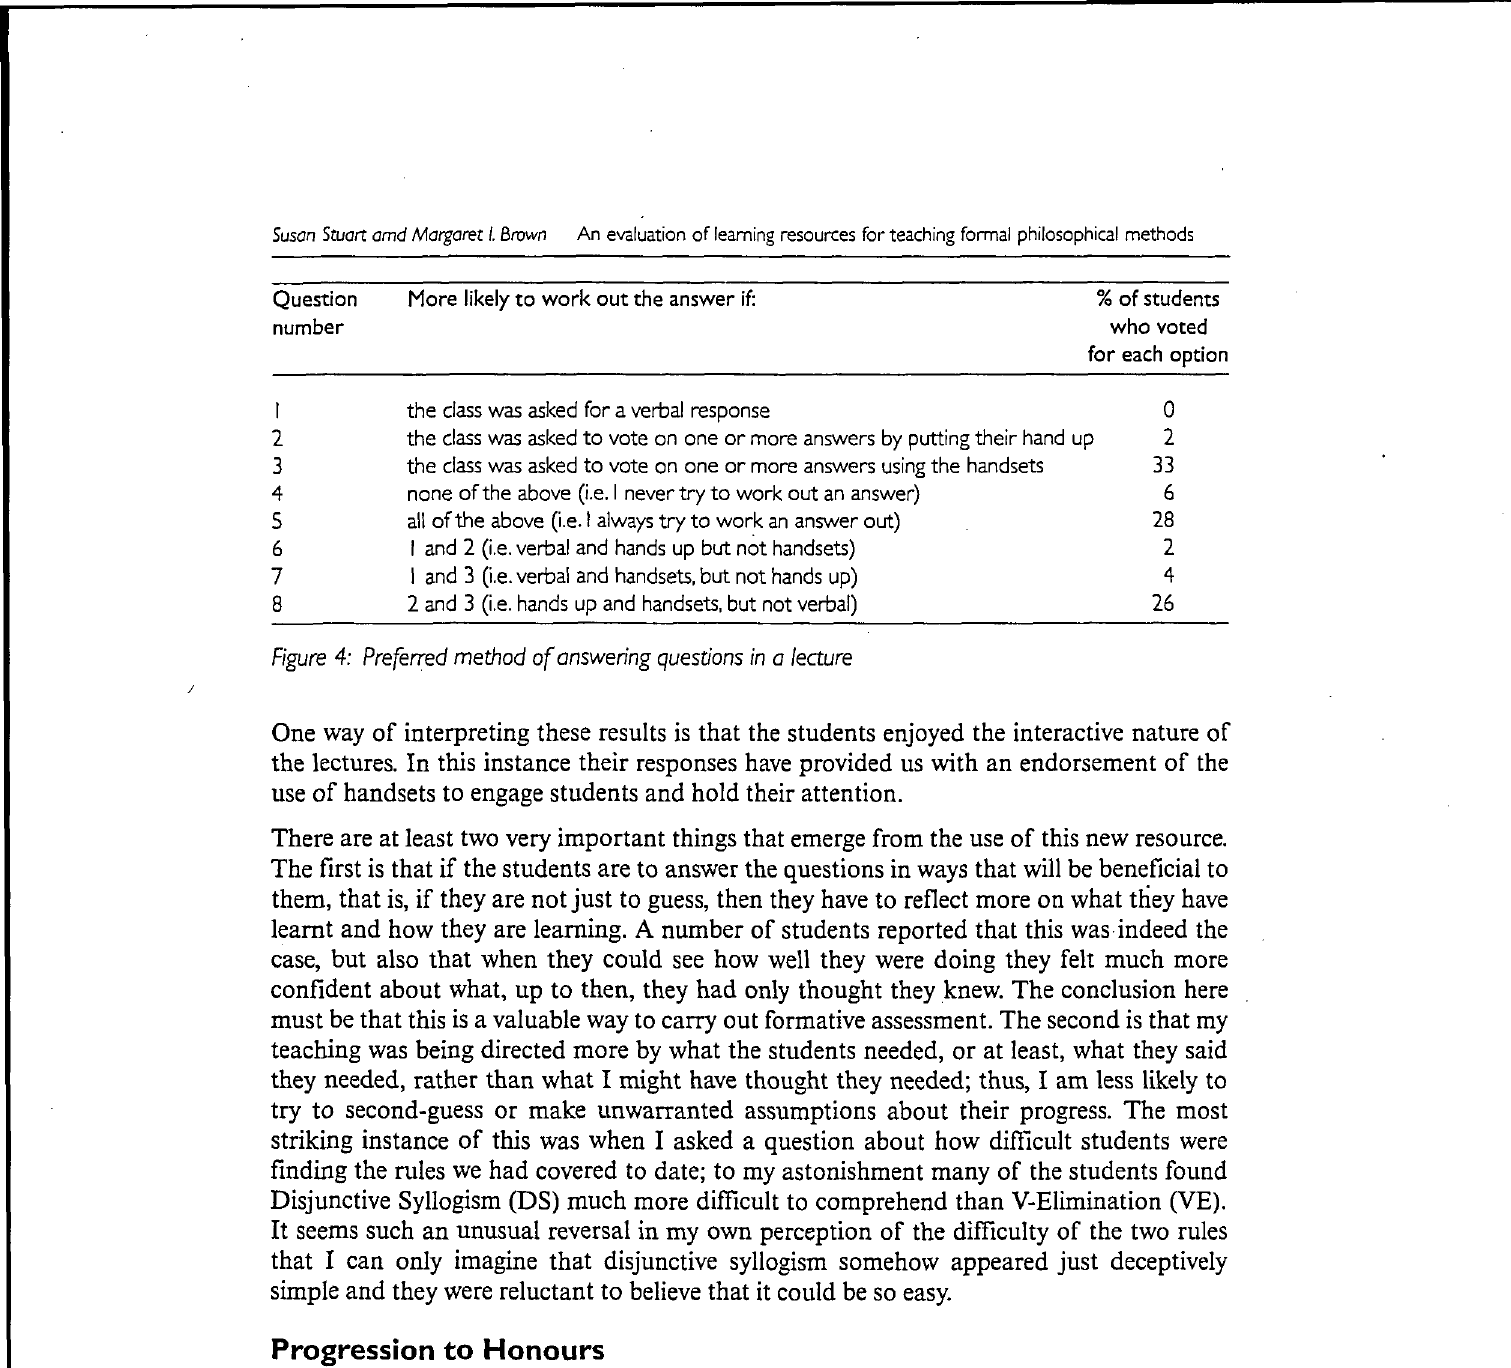
Figure 4: Preferred method of answering questions in a